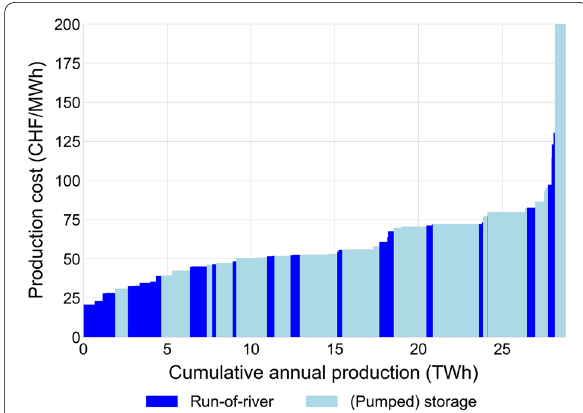
Fig. 2 Pseudo-merit-order curve for 2015/16. Note : In contrast to a “real” merit-order curve, the pseudo-merit-order curve shows not marginal but average production cost. On the x -axis, we see cumulative annual production instead of installed capacities. For data sources and construction, see Sect.